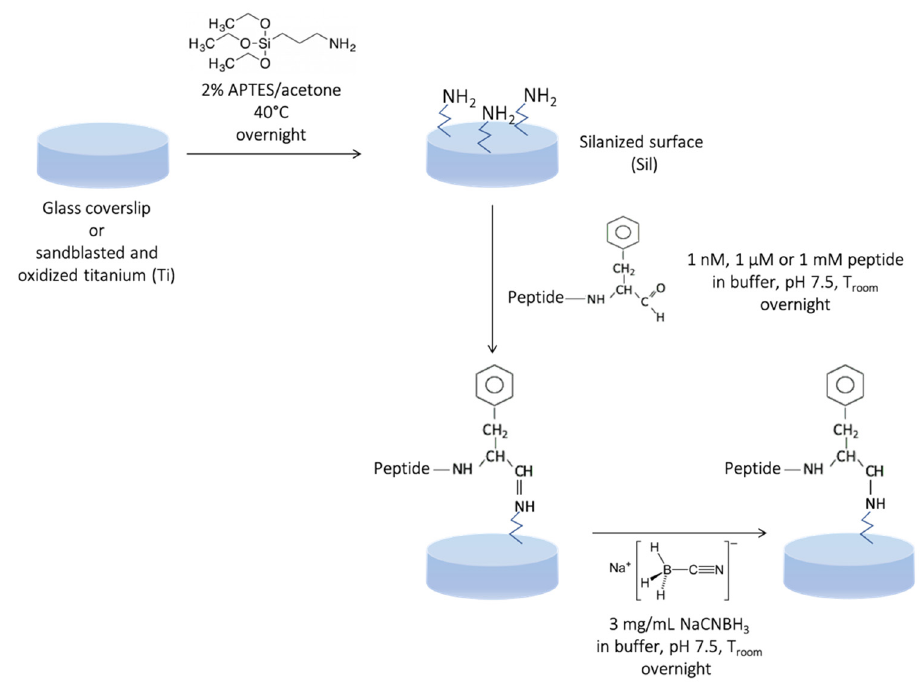
Figure 5. Scheme showing the chemistry of the peptide anchoring strategy onto glass coverslips and titanium surfaces.